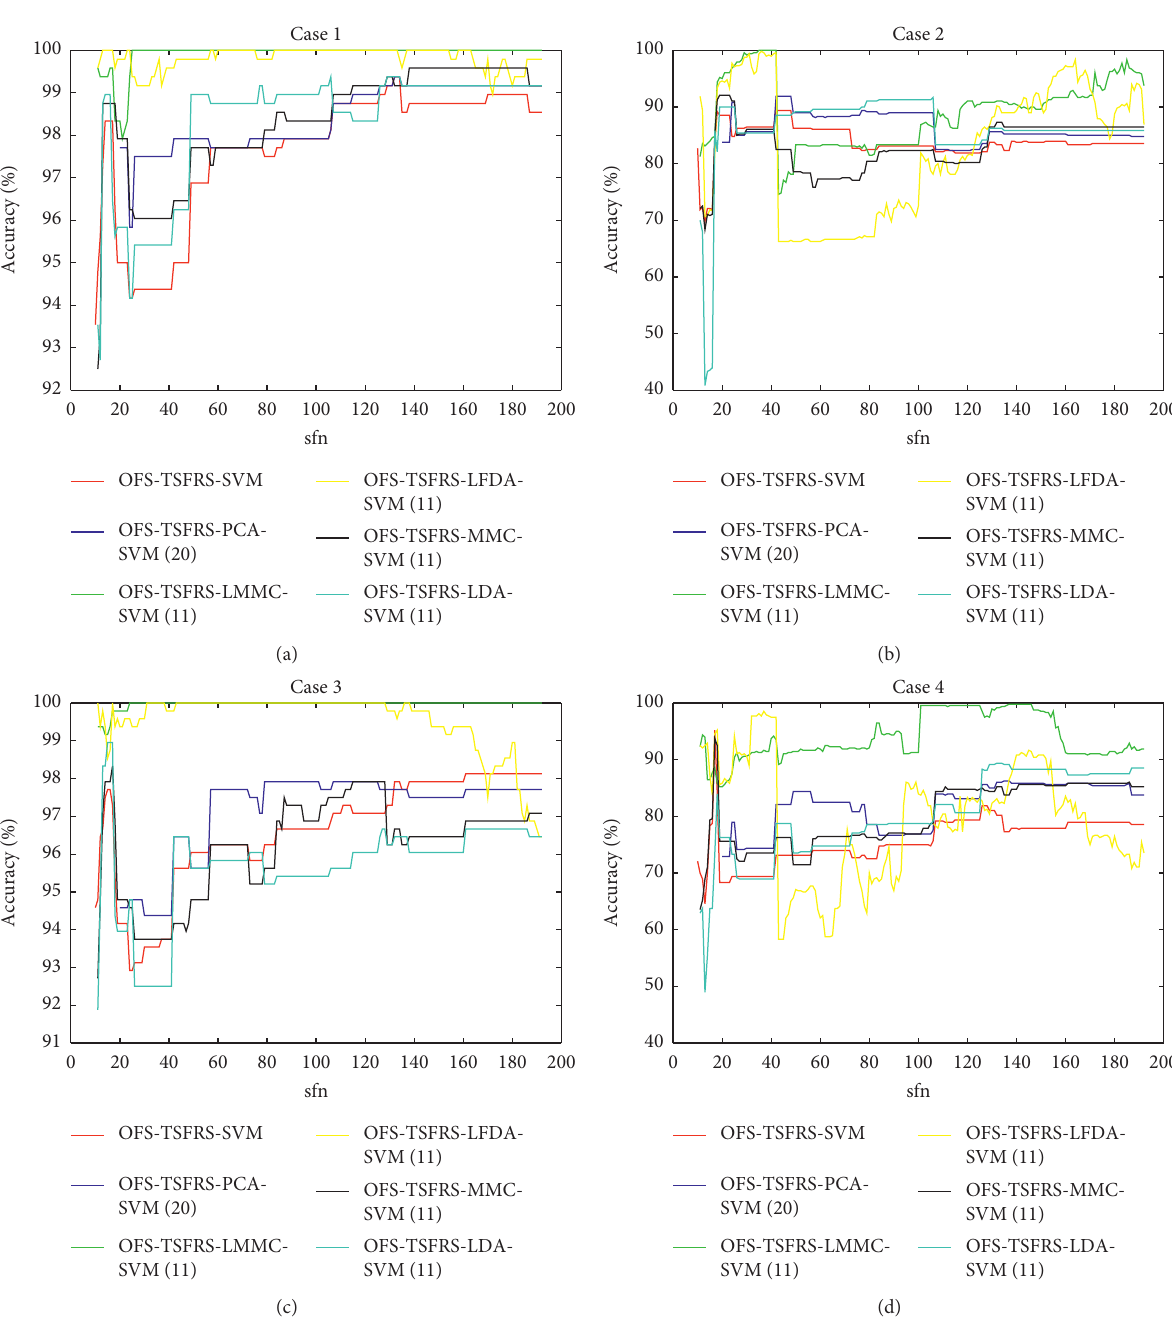
Figure 18: The curve representation of diagnosis results of models using DTCWPTfor the testing sets of two cases with the use of TSFRS and different dimensionality reduction methods. The output dimension sizes of PCA, LDA, LFDA, MMC, and LMMC are 20, 11, 11, 11, and 11,